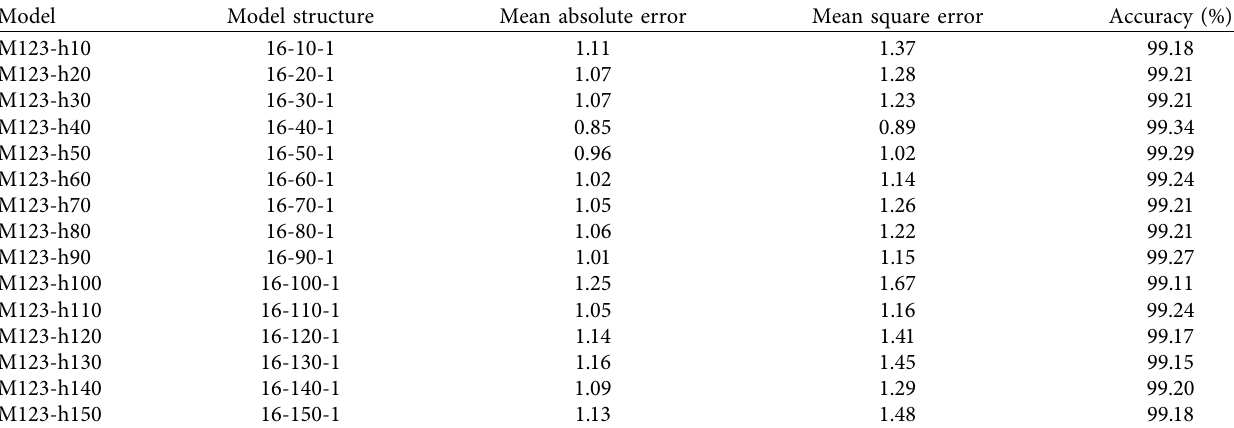
Table 7: Effects of the model’s structure on the accuracy